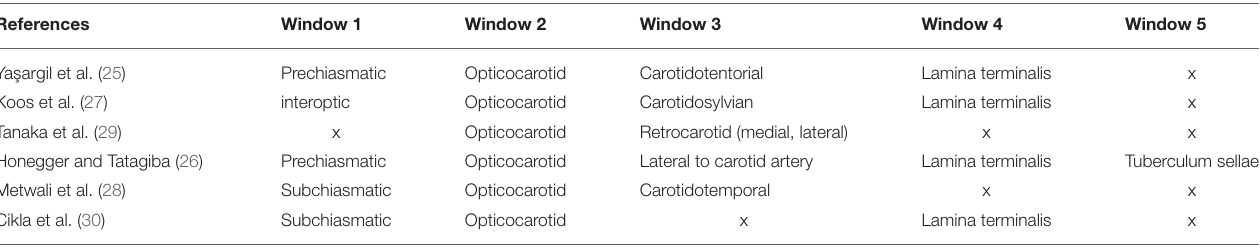
TABLE 1 | Windows around the optic chiasm: the window between the optic nerves is mostly addressed as prechiasmatic (25, 26) or IO (27) window and the window lateral to the carotid artery as the carotidosylvian (27), carotidotemporal (28), retrocarotid (29), or carotidotentorial (25)